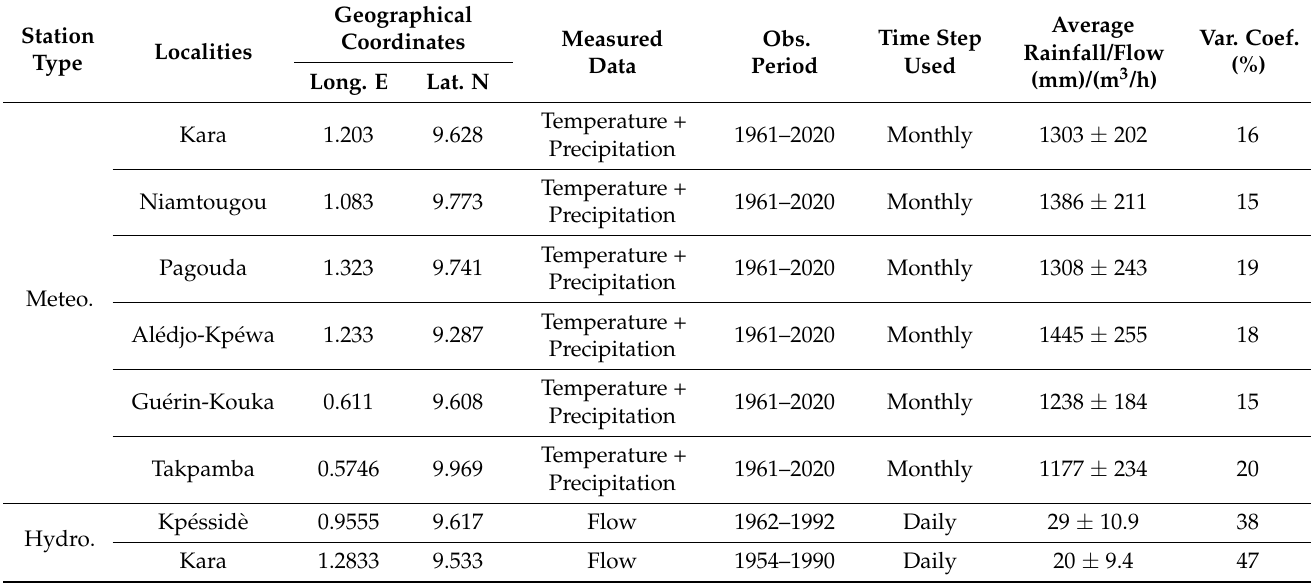
Table 1. Characteristics of the hydrometric and hydrological stations. (Meteo. = meteorological; Hydro. = hydrometric; Long. = longitude; Lat. = latitude; Obs. = observation; Var. Coef. = variation